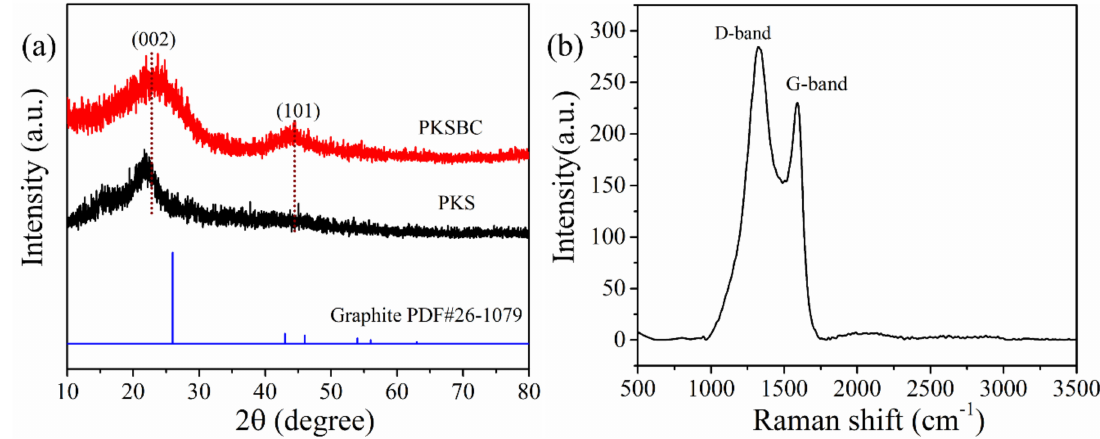
Figure 4. XRD patterns of PKS and PKSBC ( a ) and Raman spectra of PKSBC ( b ).